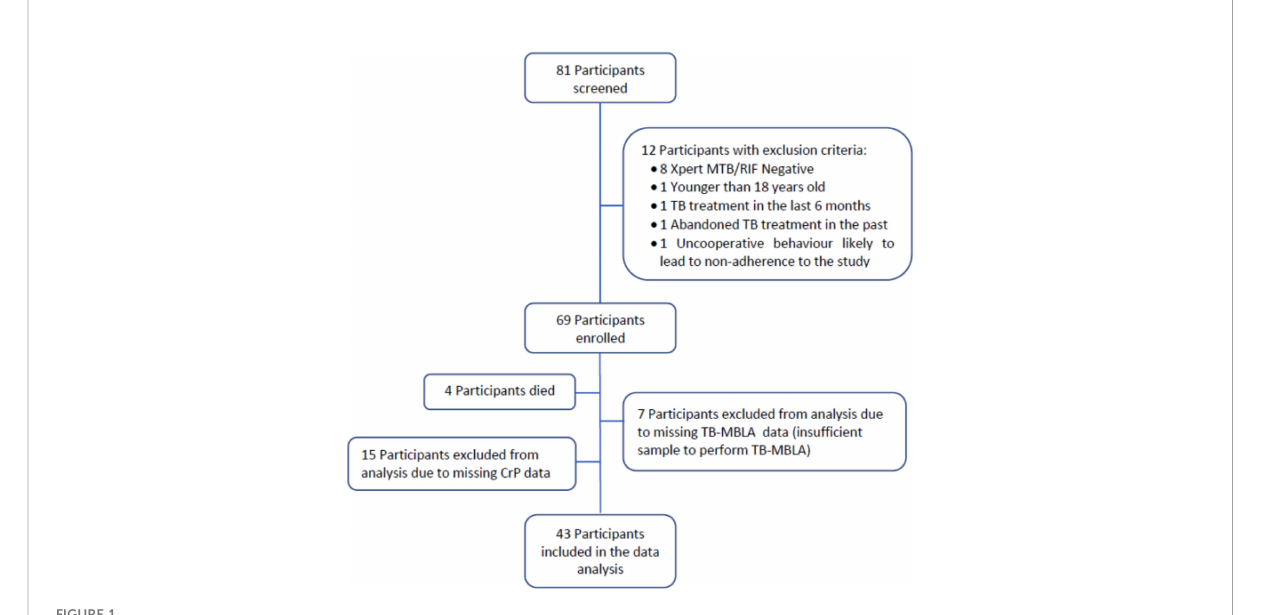
FIGURE 1 Participant fl ow